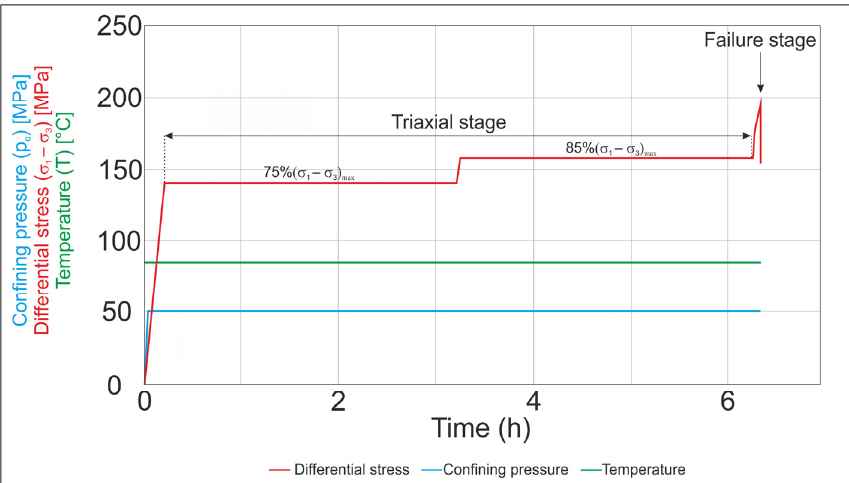
Figure 5. Schematic diagram of the brittle creep test (BCT).